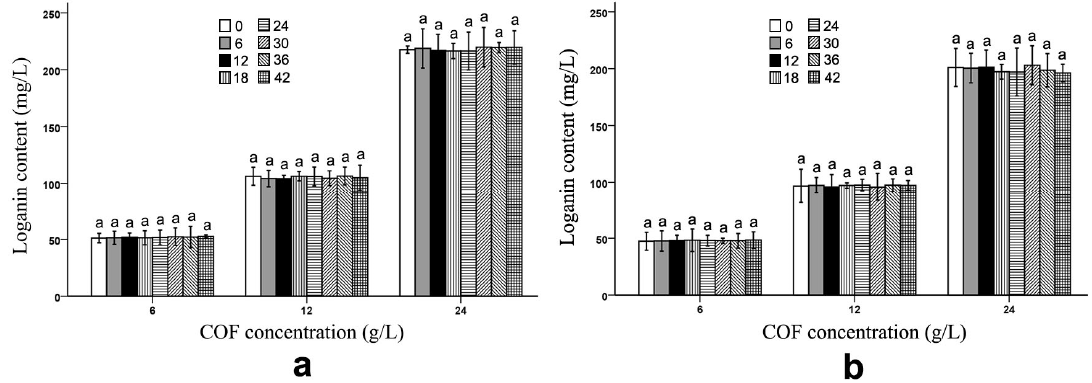
Figure 3. Loganin content in Cornus officinalis fruit (COF) culture broth at different concentrations and fermentation times of Bacillus subtilis and Bifidobacterium bifidum . ( a ) Loganin content in COF culture broth at different concentrations and fermentation duration of B. subtilis . ( b ) Loganin content in COF culture broth at different concentrations and fermentation duration of B. bifidum . Data are the means ± SD from three independent tests. Letters (a) on the error bars indicate significant differences at p < 0.05 between the loganin contents of different fermentation durations on the same COF concentration and strain. The significant differences ( p < 0.05) of the mean values were detected by T-test.